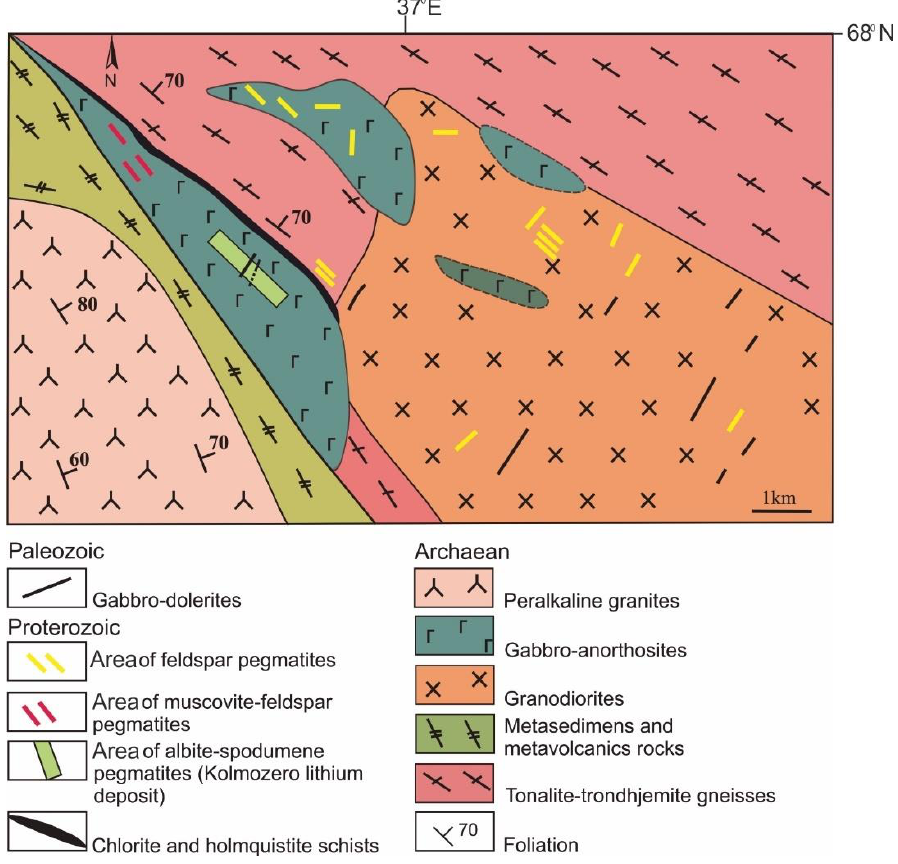
Figure 2. Schematic geological map of the Kolmozero pegmatite field. Modified after Morozova [15].